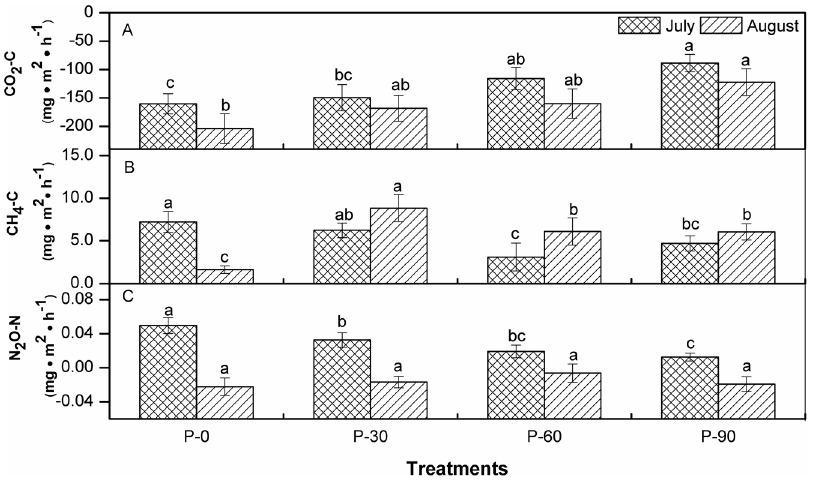
Figure 2. Emission intensities of greenhouse gases responding to phosphorus application for samplings in July and August. The different letters listed above bars represent significant differences at p , 0.05 (Duncan LSD test).